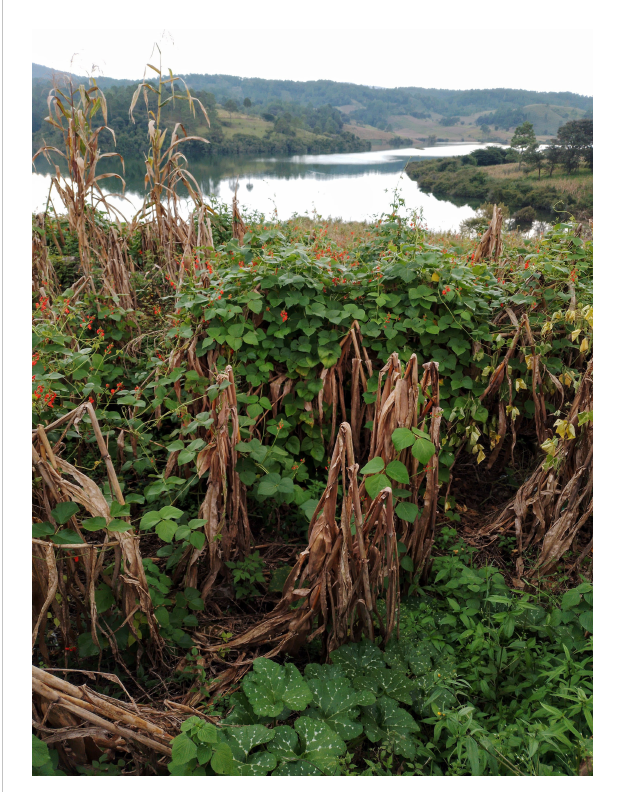
FIGURE 2 Maize, bean and squash in milpa fi eld in Tojolabal, Chiapas.